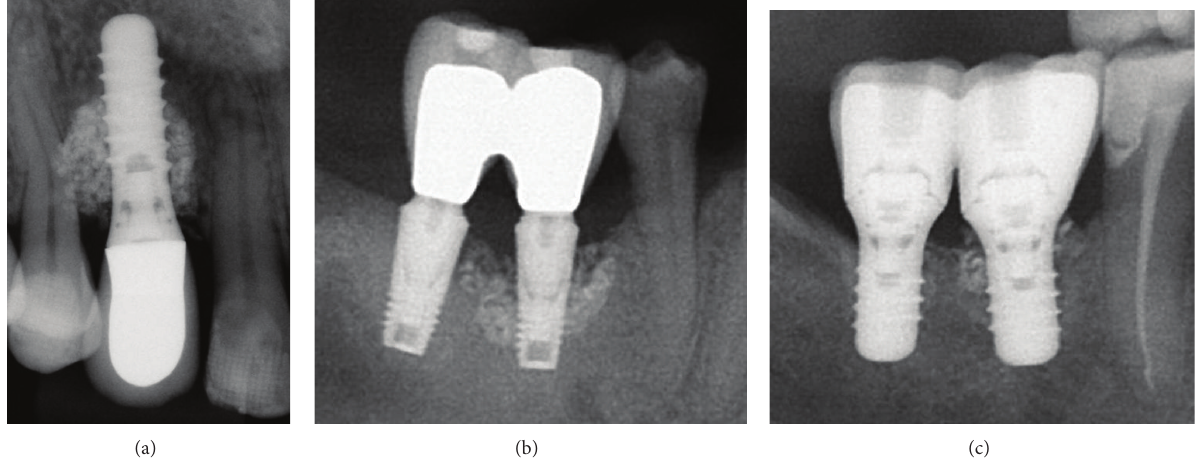
Figure 5: Radiological followup of patients 1, 2, and 4 after 26, 12, and 9 months, respectively, after surgery.